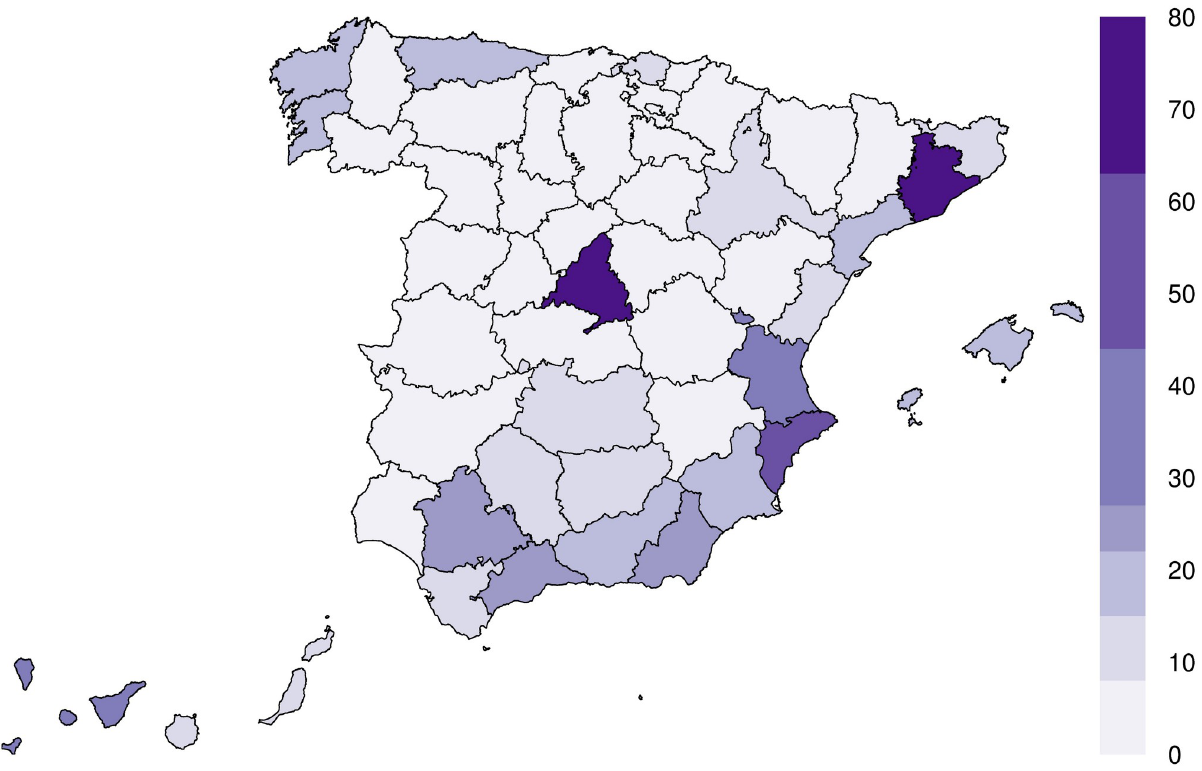
Fig 1. Geographical occurrence of femicides in Spain. Work derived from BDLJE May 2018 CC-BY 4.0 scne.es.